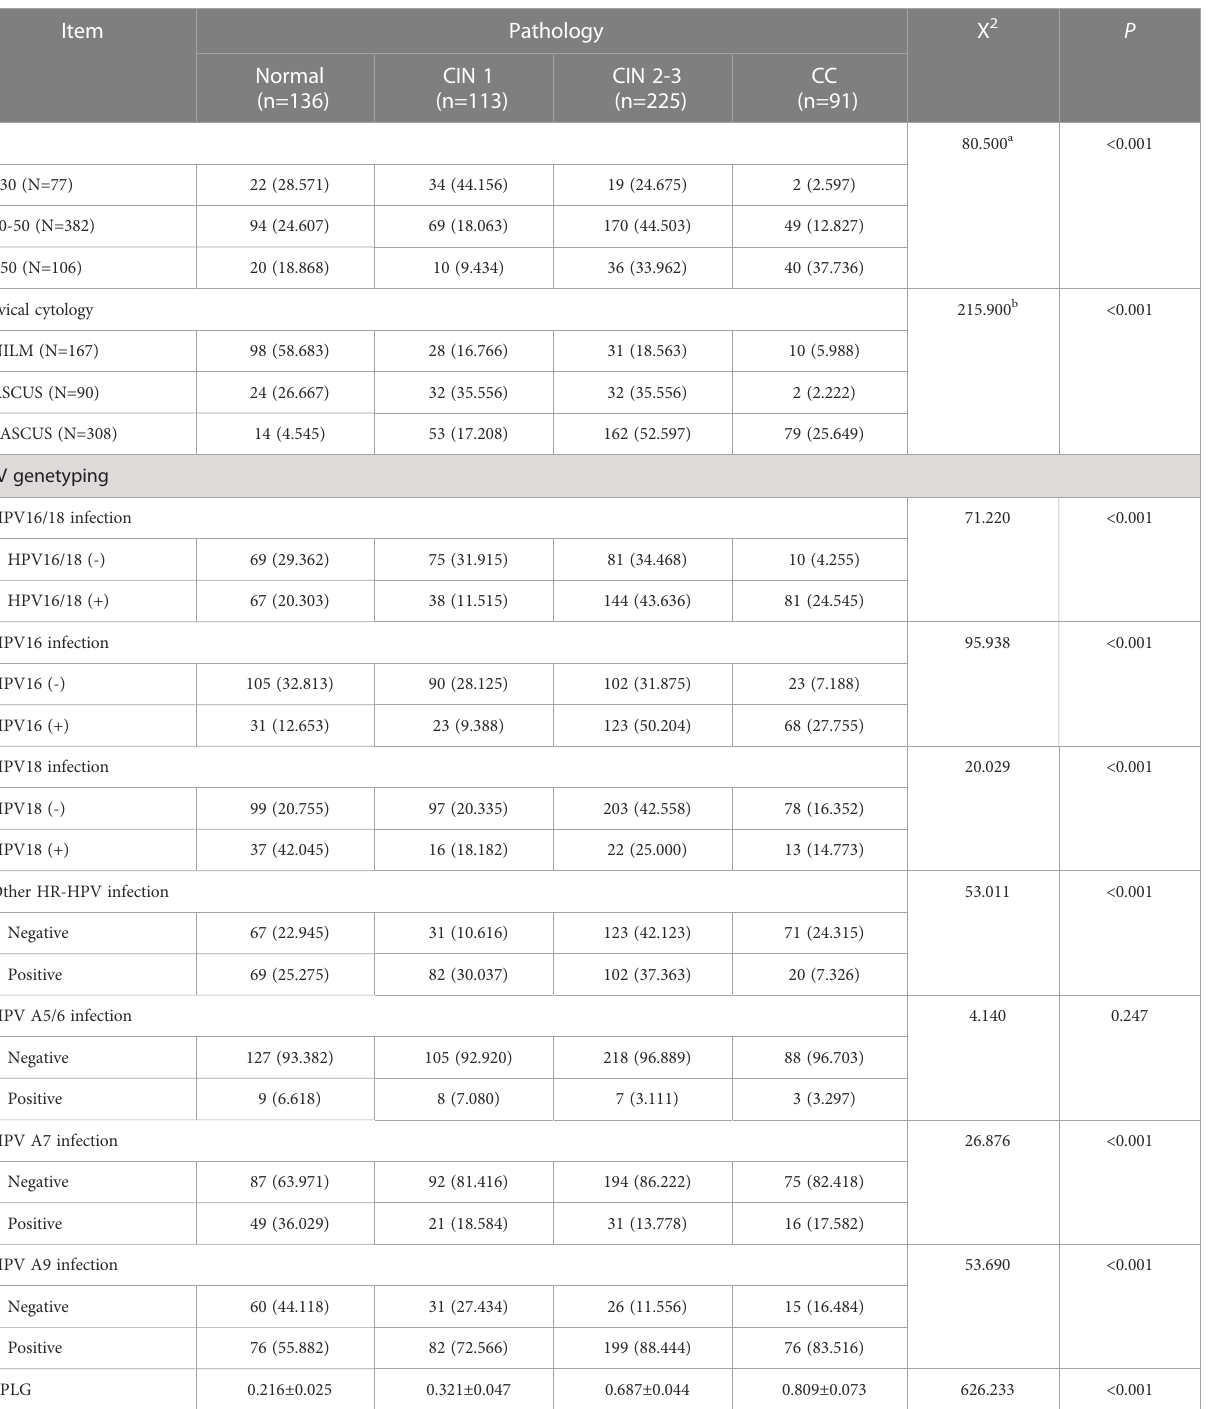
TABLE 1 Clinical characteristics of the participants of the study [N